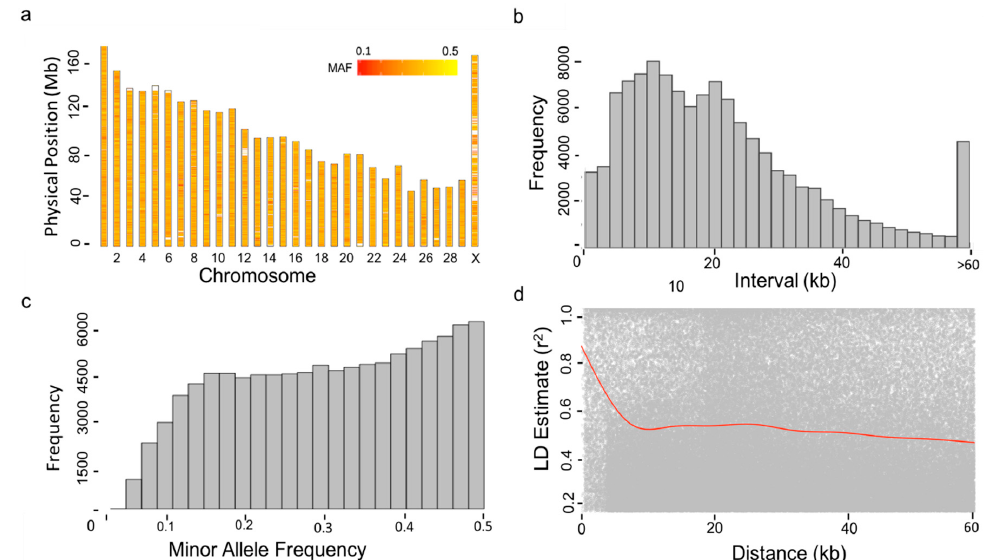
Figure 1. Properties of Single Nucleotide Polymorphisms (SNPs). A total of 1220 cows were genotyped by the Illumina Bovine 150 k BeadChip. After conducting quality control on both minor allele frequency (MAF, above 5%) and missing rate ( < 10%), 1220 individuals and 124,743 SNPs remained. The distribution of the filtered SNPs is displayed over the 30 bovine chromosomes except for Y chromosome ( a ). The MAFs of SNPs were re-calculated after the filtering and were displayed by a heat map. Consequently, the SNPs with MAF < 5% remained, as demonstrated by the histogram ( c ). The density of SNPs is displayed by the frequency of the distance between adjacent SNPs ( b ). The distances over 60 kb clustered into one group. The maximum distance was 100.06 kb. Pairwise Linkage Disequilibrium (LD) was calculated as the R square for SNPs within the 100 kb window. The decay of LD over distance (red line) is displayed by the pairwise LD and moving average ( d ).